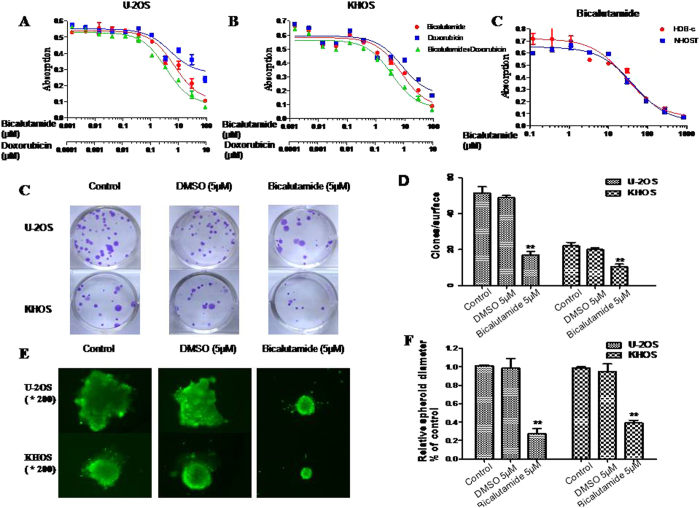
Effects of AR inhibitor bicalutamide in osteosarcoma cell lines.(A,B) Bicalutamide inhibits osteosarcoma cell viability. Cells were treated with bicalutamide or doxorubicin or the combination at the indicated concentrations. The relative sensitivity of each line was determined by MTT. (C,D) Bicalutamide inhibits colony formation units in osteosarcoma cell line U-2OS and KHOS. (E,F) Bicalutamide suppresses sphere formation of U-2OS and KHOS in three-dimensional culture. Spheroids formation of different cells after 7-day culture and the relative diameters compared with untreated cells. The assay was conducted in duplicate. *P < 0.05, **P < 0.01 (compared with control cells).